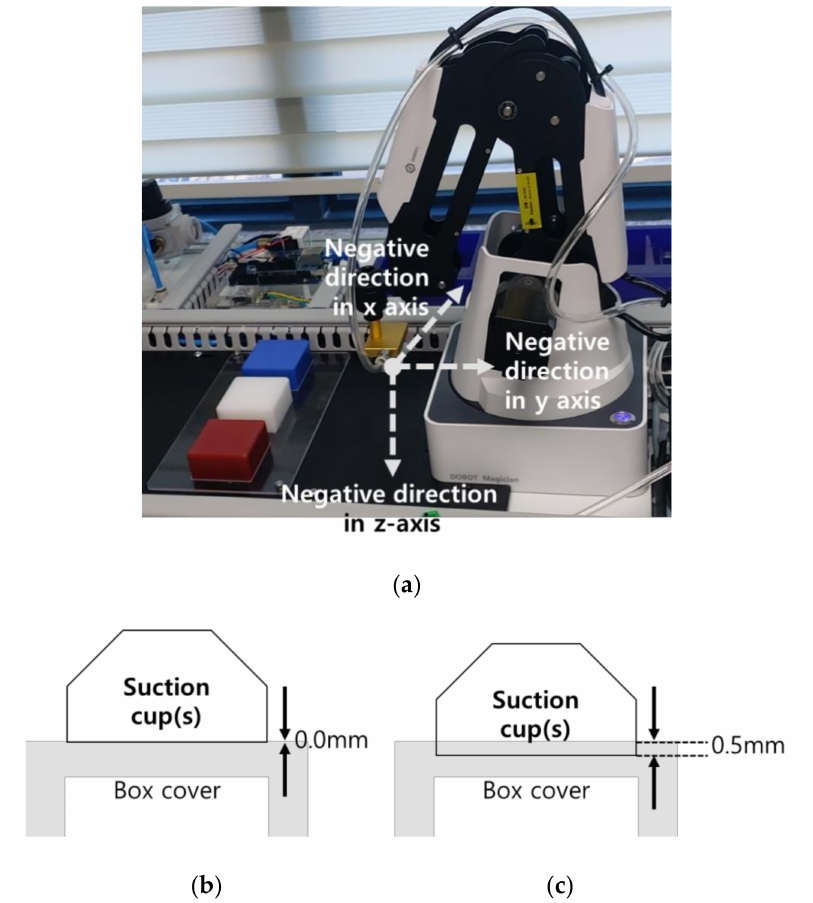
Figure 7. Suction cup positions for predictive process adjustment: ( a ) axis information for suction cup control; ( b ) diagram for the 0.0 mm z-position; ( c ) diagram for the − 0.5 mm